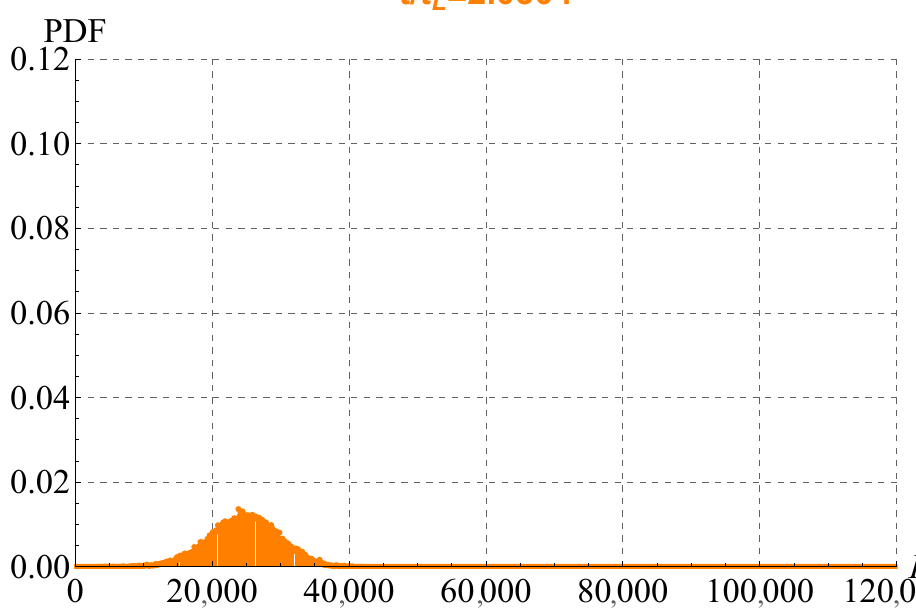
Figure 9. Probability density function (PDF), solution of Equation (36). Screenshoot at time ˆ t =